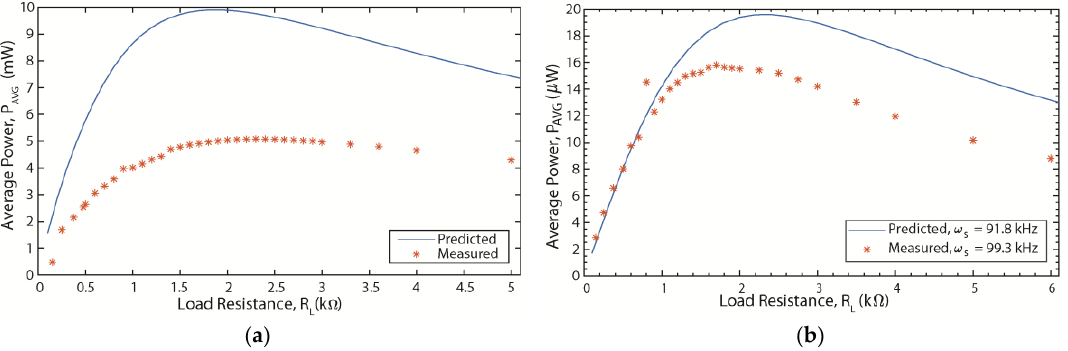
Figure 12. ( a ) Power output vs. load resistance for Galfenol-PZT device operating at 70.7 kHz. ( b ) Power output vs. load resistance for Metglas-PVDF device operating at 99.3 kHz.